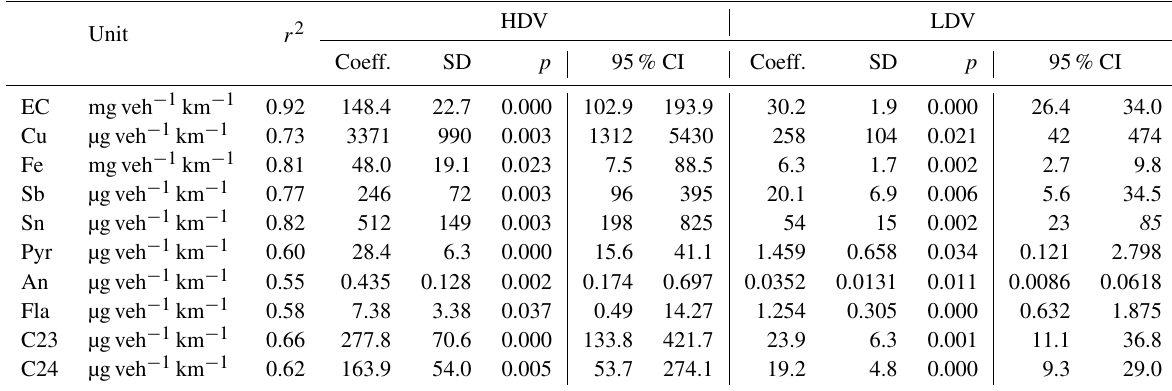
Table 3. Results of the multiple linear regressions with the heavy-duty traffic (HDV) and the light-duty traffic (LDV): square correlation coefficients, unstandardized coefficients with standard deviations for HDV and LDV, p values and 95% confidence intervals (CI). HDV LDV Unit r 2 Coeff. SD p 95% CI